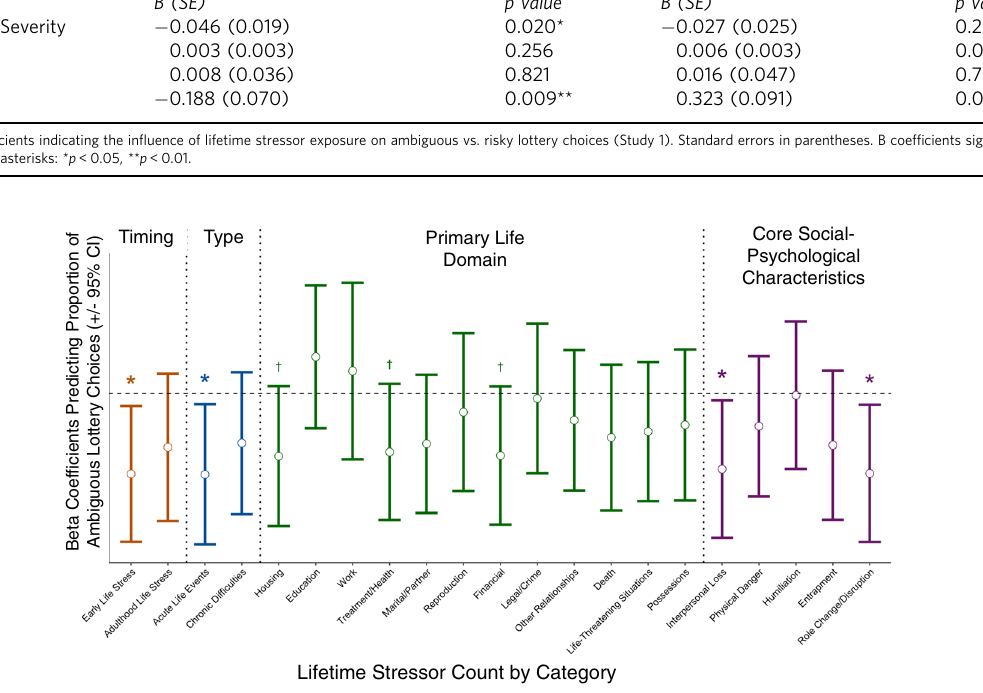
Fig. 5 Stressor-speci fi c effects on ambiguous lottery choice (Study 1). Standardized beta coef fi cients derived from linear regressions depicting the relation between lifetime stressor count and proportion of (risk-corrected) ambiguous lottery choices controlling for age and gender. Stressors on the y-axis are categorized by stressor timing (early life vs. adulthood), type (acute vs. chronic), primary life domain, and core social-psychosocial characteristic. Acute stressors ( p = 0.024) and those experienced in early life ( p = 0.021) were both predictive of ambiguous choice behavior, especially those marked by Interpersonal Loss ( p = 0.032) or Role Change/Disruption ( p = 0.023). Errors bars indicate 95% CI. Tests are uncorrected for multiple comparisons. * p < .05, † p < .10. ( N =